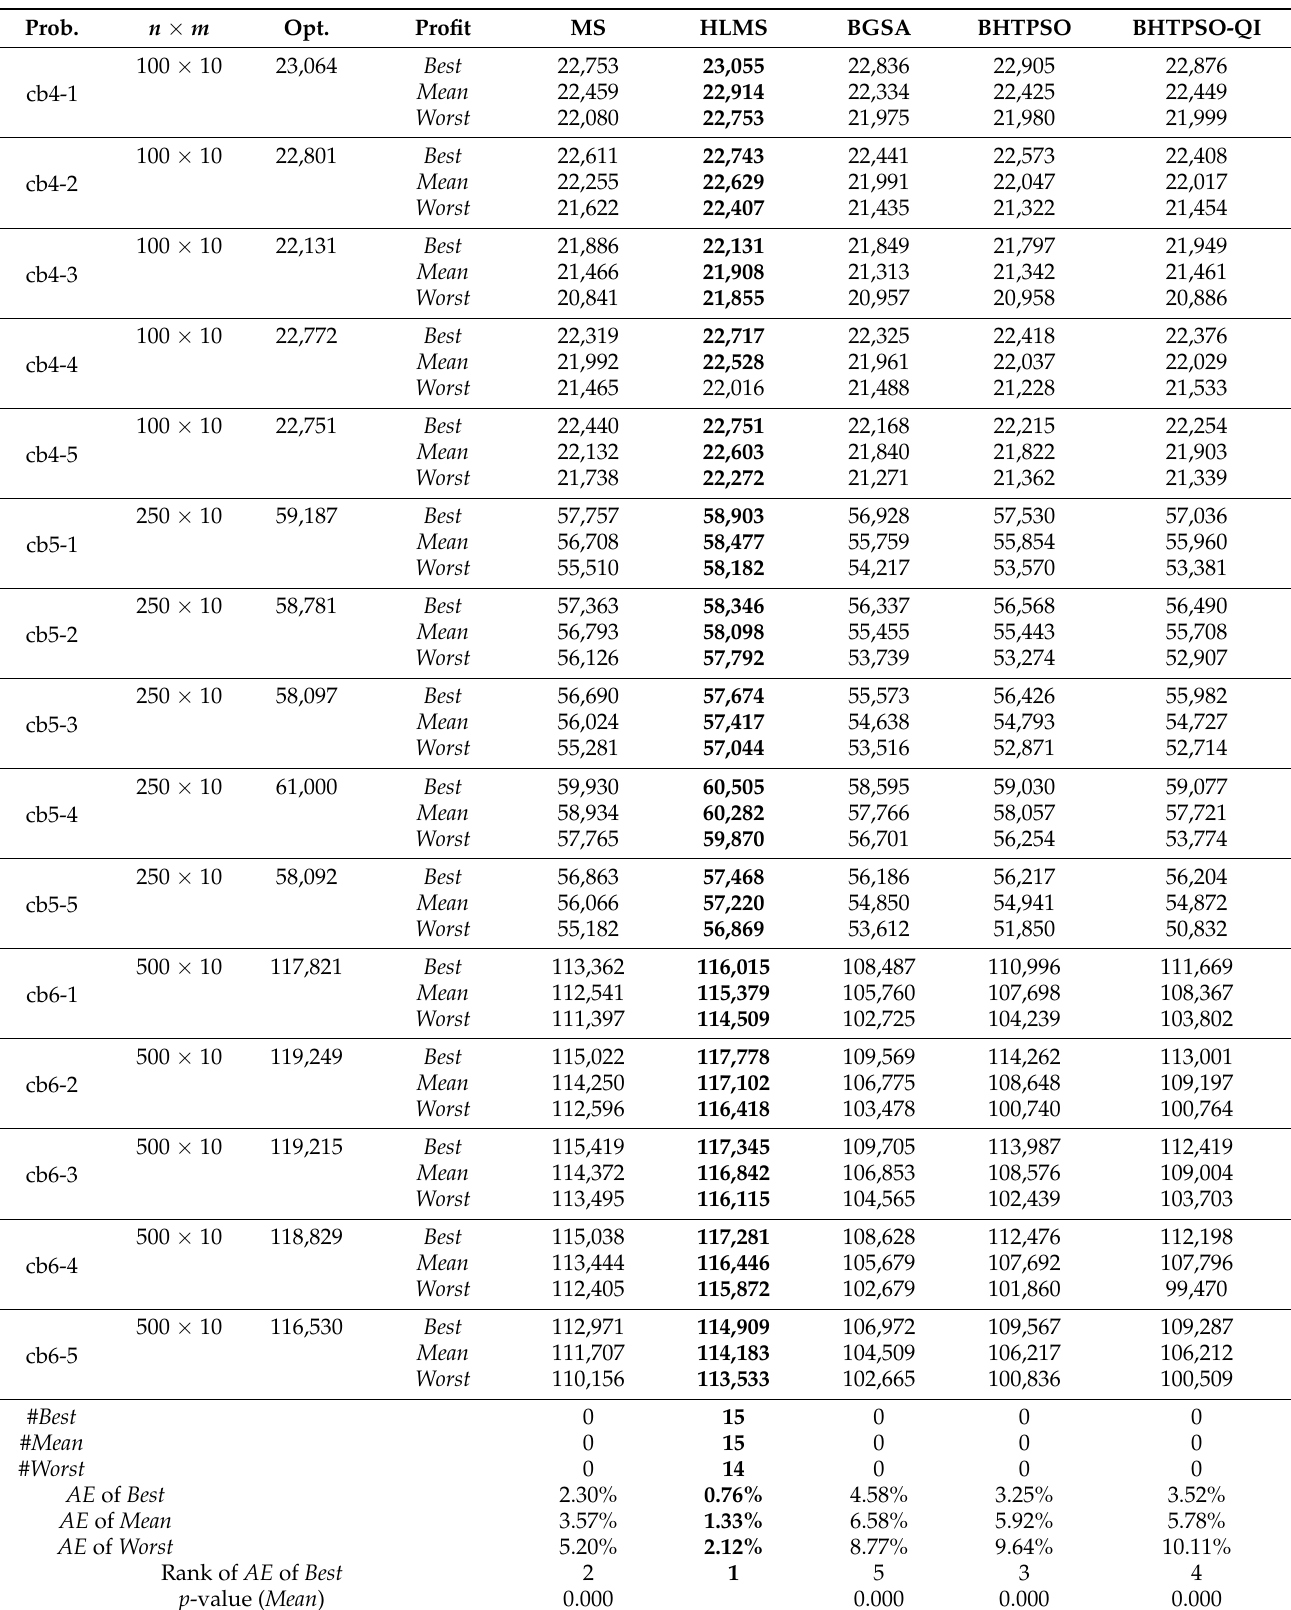
Table 5. The results of HLMS with 5 comparative algorithms for Test set III (cb4–cb5).